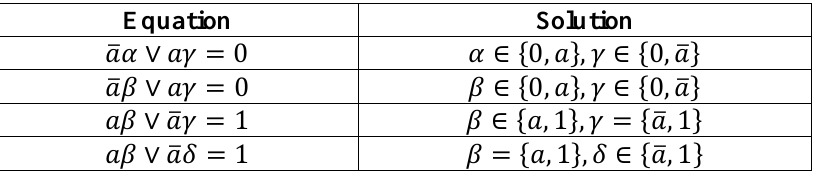
Table 2. Equations resulting from constraints of example